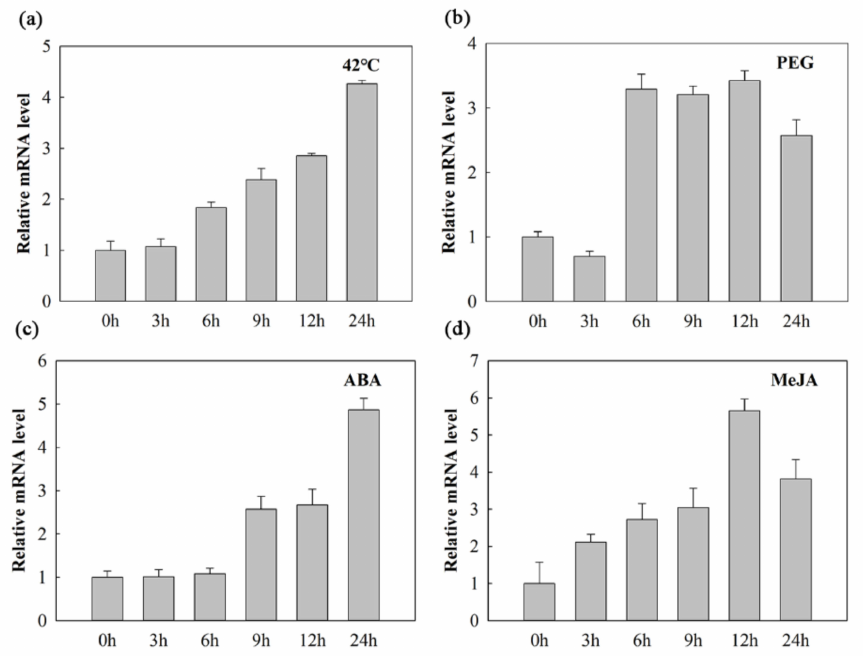
Figure 3. Expression profile analysis of SlEGY2 under different abiotic stress treatments. ( a ) 42 ◦ C. ( b ) 20% PEG6000 ( w / v ). ( c ) 100 µ M ABA. ( d ) 100 mM